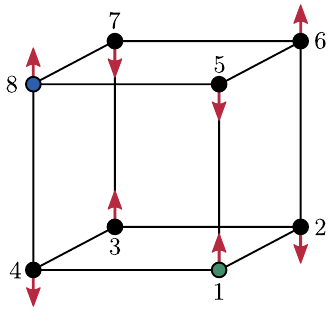
Figure 8: A schematic representation of the three-dimensional Fermi-Hubbard lattice. The (red) arrows give a qualitative indication of the initial spin configuration, which we use to initialise the charge and spin dynamics shown in Fig. 9 for sites 1 and 8.